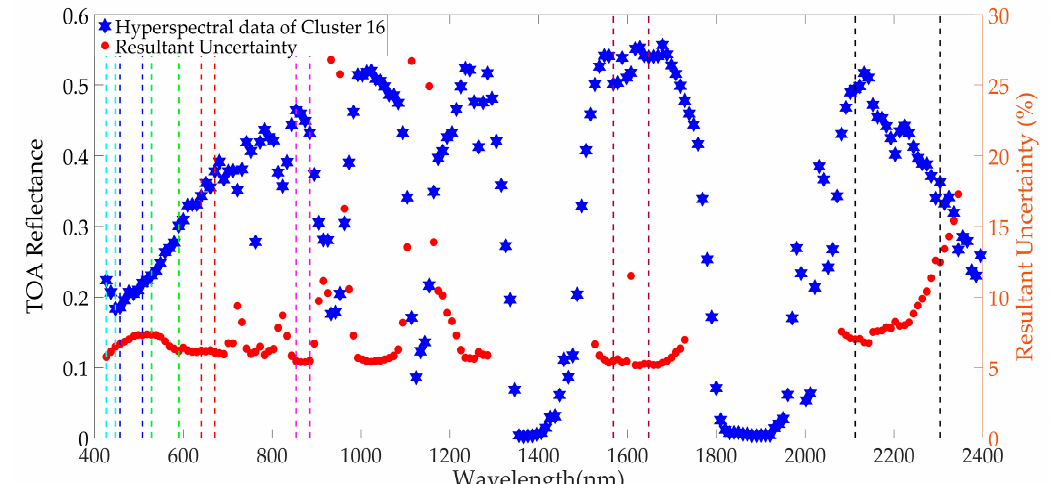
Figure A13. Estimated representative hyperspectral profile of Cluster 16 and its resultant uncertainty.